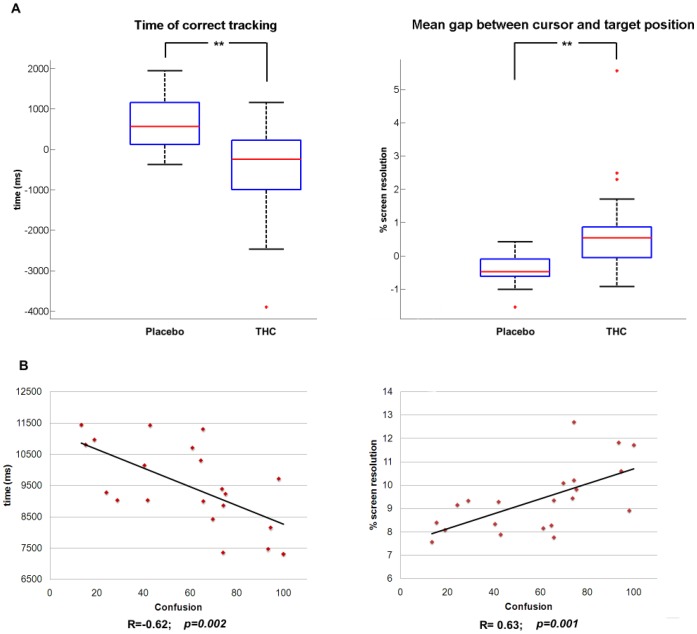
Behavioural results during fMRI session.(A) Comparison of the main behavioural data between two experimental sessions (Placebo/THC). Effects of THC/placebo inhalation were assessed by subtracting the performance during the second post-THC/placebo sessions from the performance during the first control sessions. The red central mark is the median, the edges of the box are the 25th and 75th percentiles, the whiskers extend to the most extreme datapoints that the algorithm considers not to be outliers (1.5 times the interquartile range), and the outliers are plotted individually with red crosses. Black stars represent the significant difference of the variable of interest in the two experimental conditions. (B) Linear correlation between the duration of correct tracking and the feeling of confusion (left panel) and linear correlation between the deviation between target and cursor and the feeling of confusion (right panel). Corresponding Pearson’s correlation coefficients (R) and p-values are displayed at the bottom of each plot.